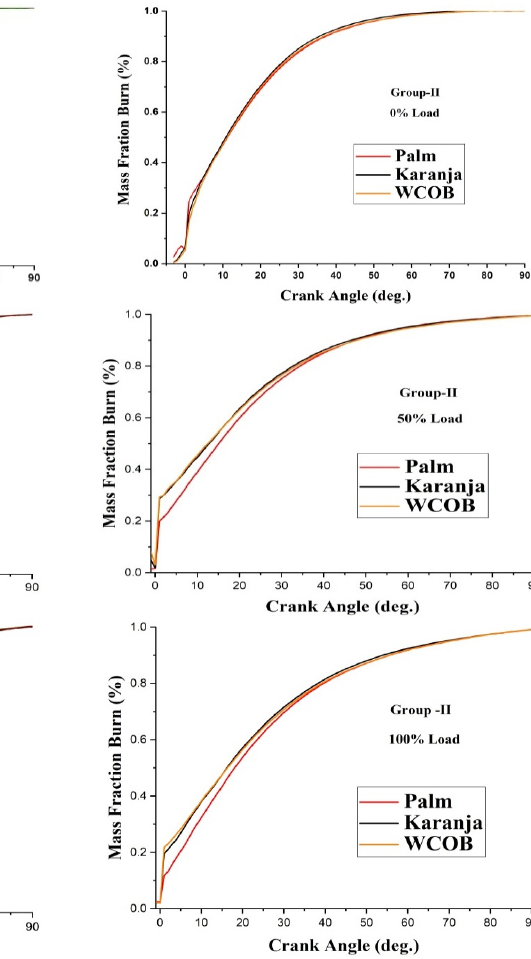
Figure 4. Mass fraction burnt rate for various biodiesels at 0%, 50%, and 100% load.